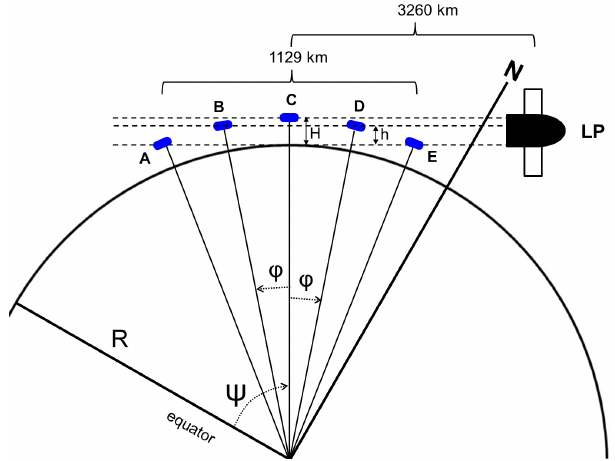
Figure 3. The diagram for observations of a limb sensor, showing the relationship between the observed ( h ) and real ( H ) heights of one cloud in five positions, as well as ϕ – the angular displacement of the position of the cloud from the tangential point T . (cid:57) is a lati- tude. The figure is not to scale.